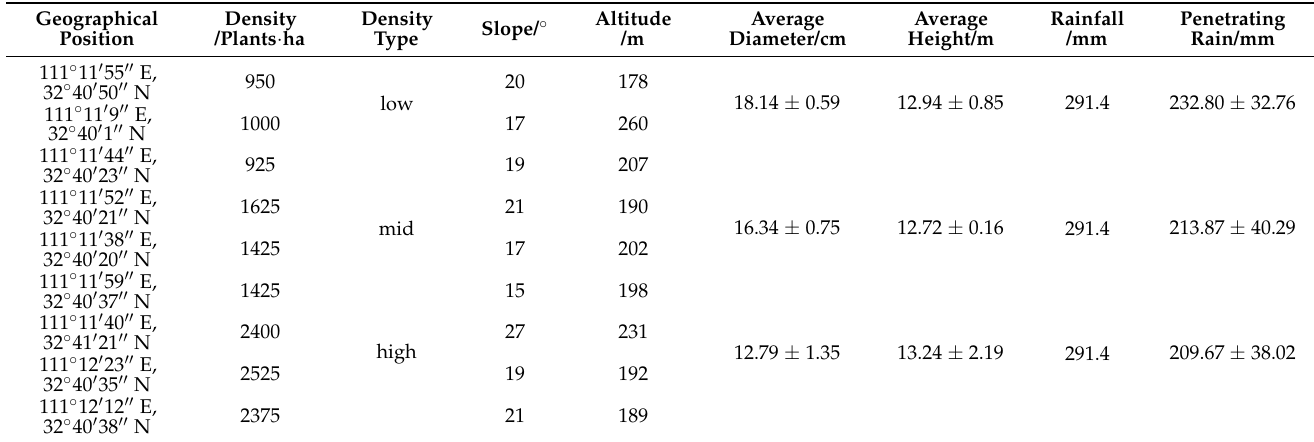
Table 1. Basic information of the survey